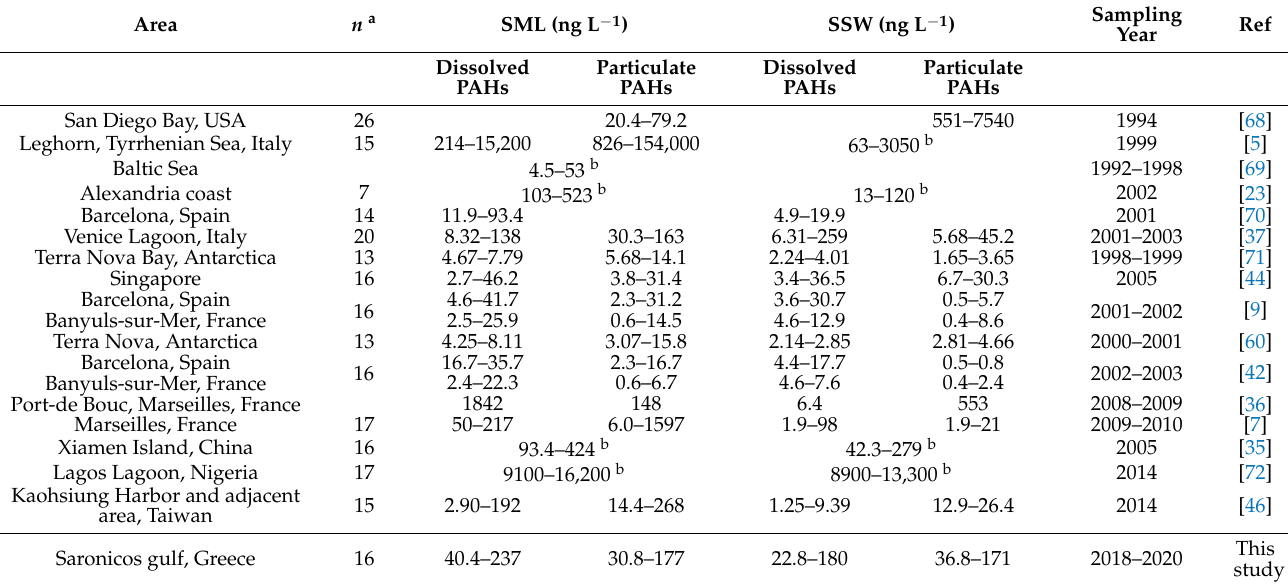
Table 5. Concentrations of ∑ PAHs in the sea surface microlayer (SML) and sub-surface water (SSW) of different coastal regions.